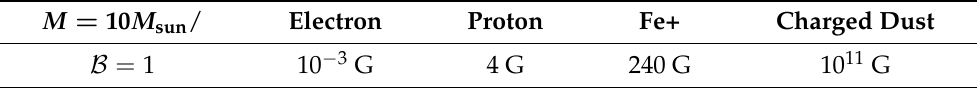
Table 1. Intensity of the magnetic field B corresponding to the magnetic parameter B = 1 for various types of charged particles moving in the vicinity of the black hole of mass M BH ∼ 10 M (cid:12)